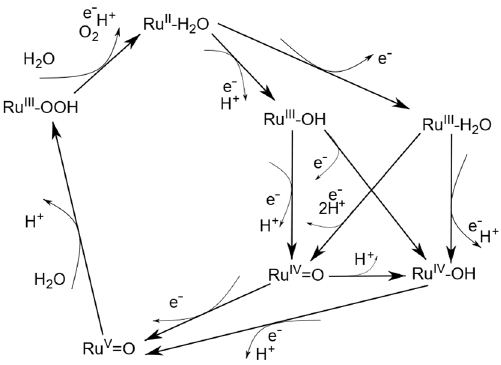
Figure 2. Possible pathways for oxidation and proton − coupled electron transfer of a WOC forming an O − O bond via water nucleophilic attack on the Ru V = O state.